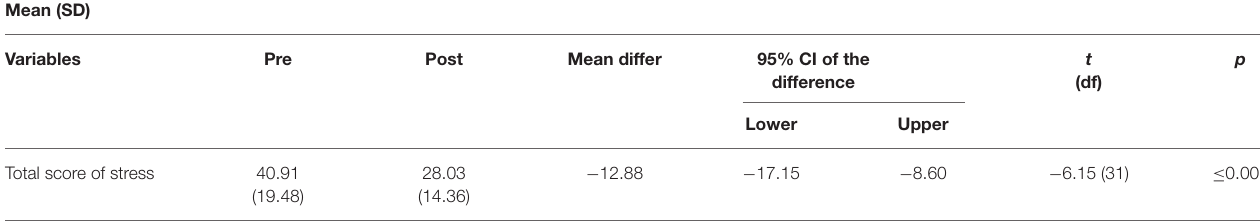
A repeated measurement ANOVA, p <